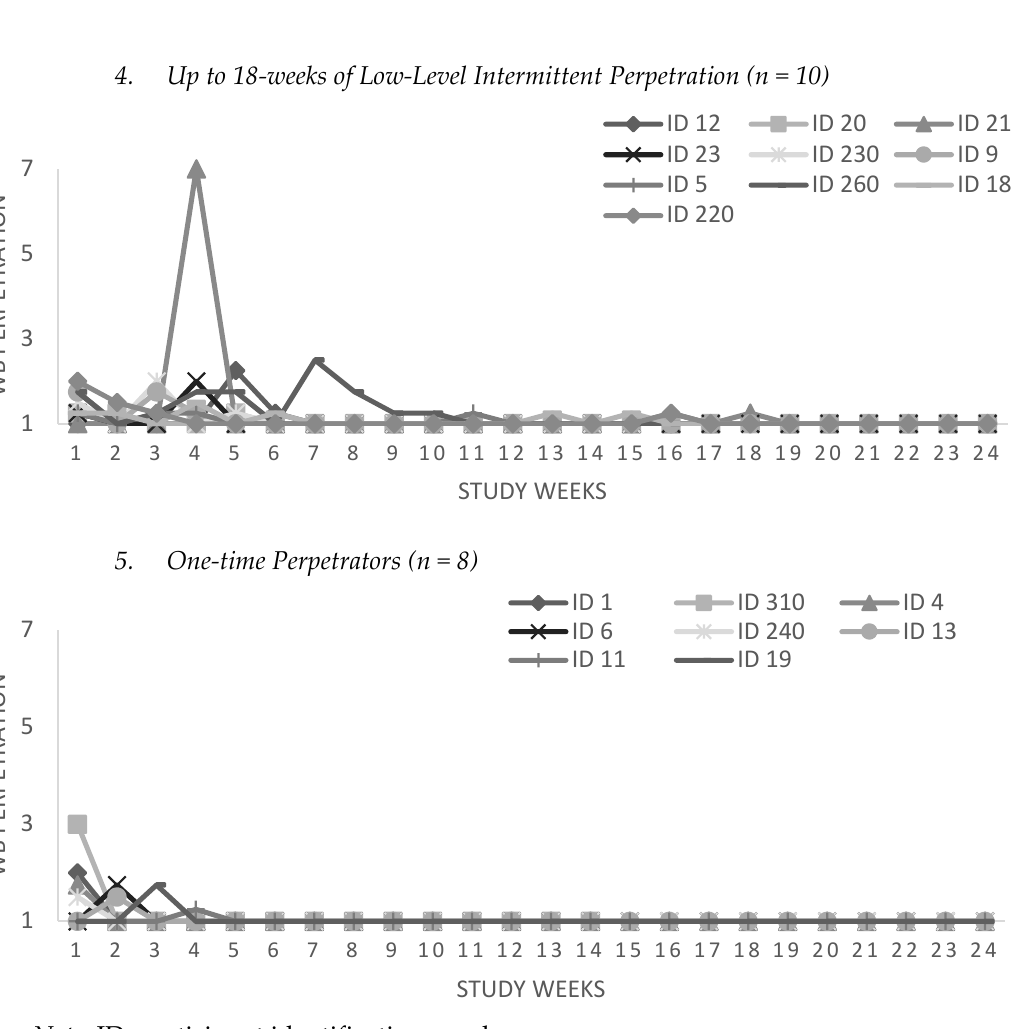
Figure 3. Groups in Diary Study by perpetration frequency, intensity and duration.